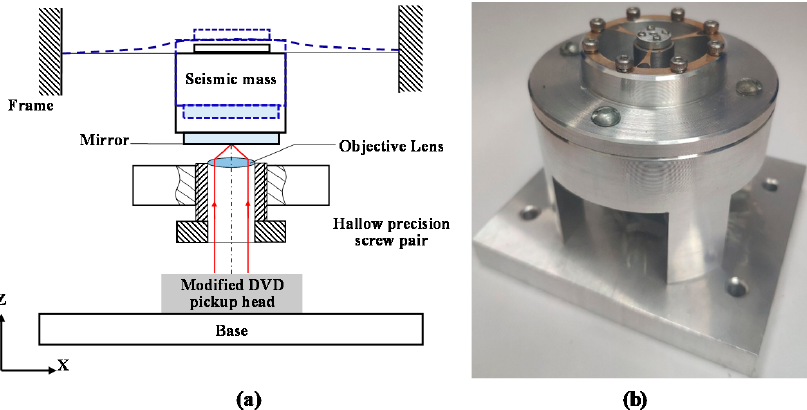
Figure 4. Accelerometer with a fully symmetric leaf spring: ( a ) structure schematic and ( b ) photo- graph. Reprinted with permission from Ref. [22]. Copyright 2019 IEEE.